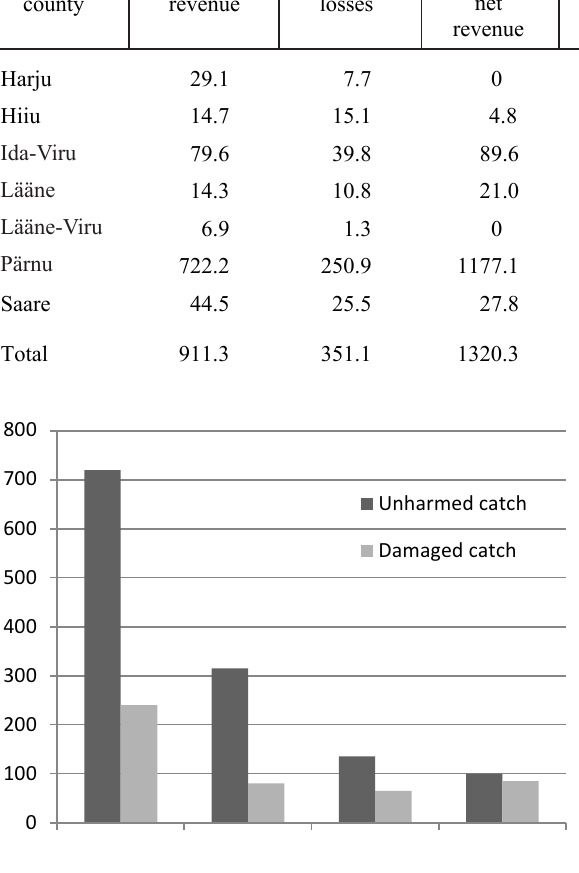
Fig. 3. Proportion of unharmed and damaged garfish in herring trap nets (without AHDs) in 2011 in locality